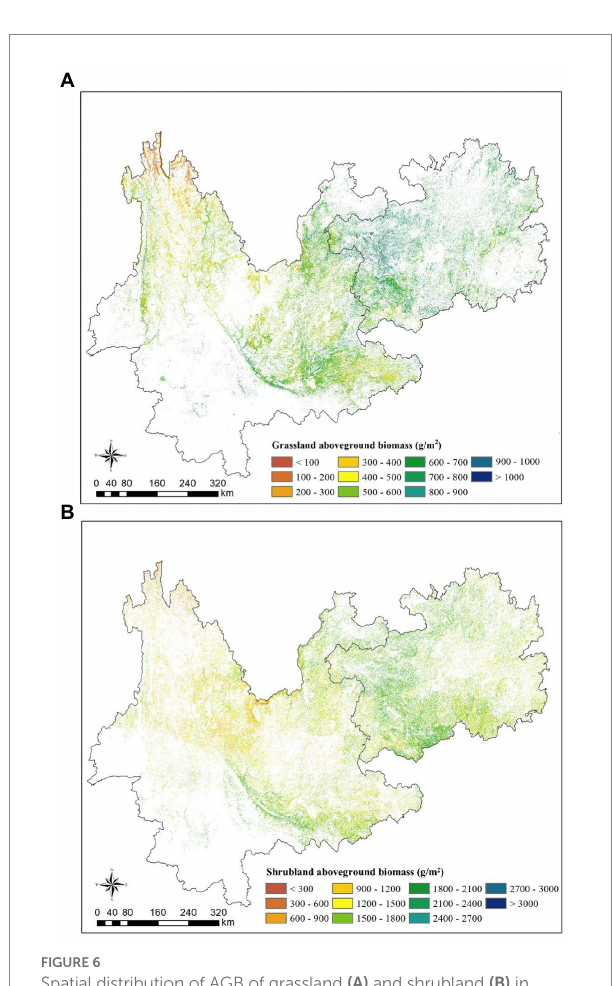
FIGURE 6 Spatial distribution of AGB of grassland (A) and shrubland (B) in Yunnan and Guizhou provinces in